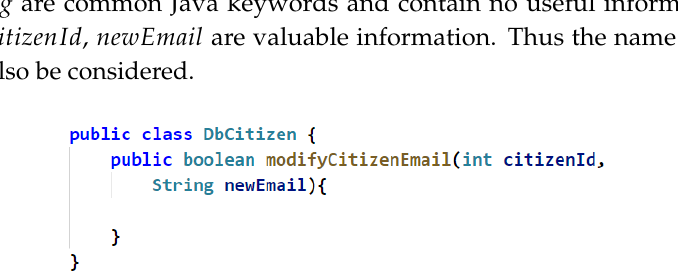
Figure 4. An example of parameter name information of a code feature.